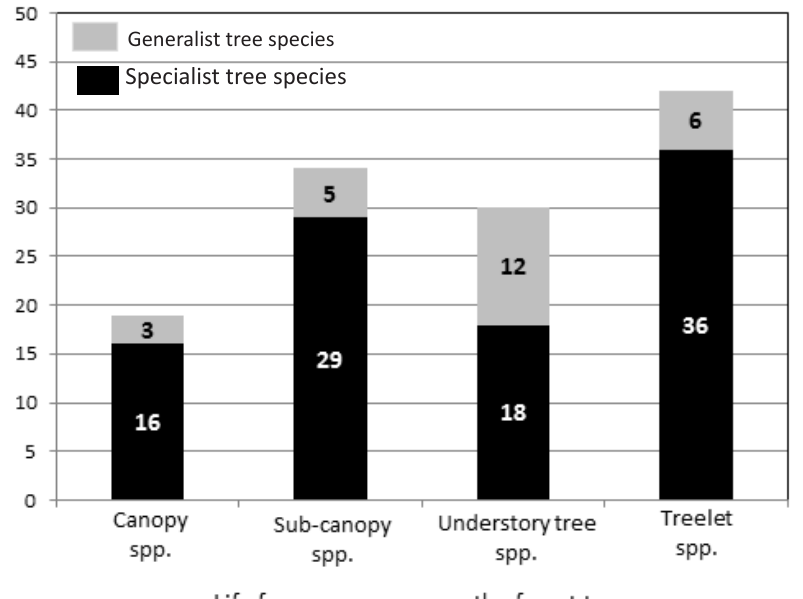
Figure 8: Habitat specialists among tree species in different lifeform categories in the 25 ha Forest Dyanamics Plot in Sinharaja World Heritage Site, Sri Lanka (from Gunatilleke et al . 2006).